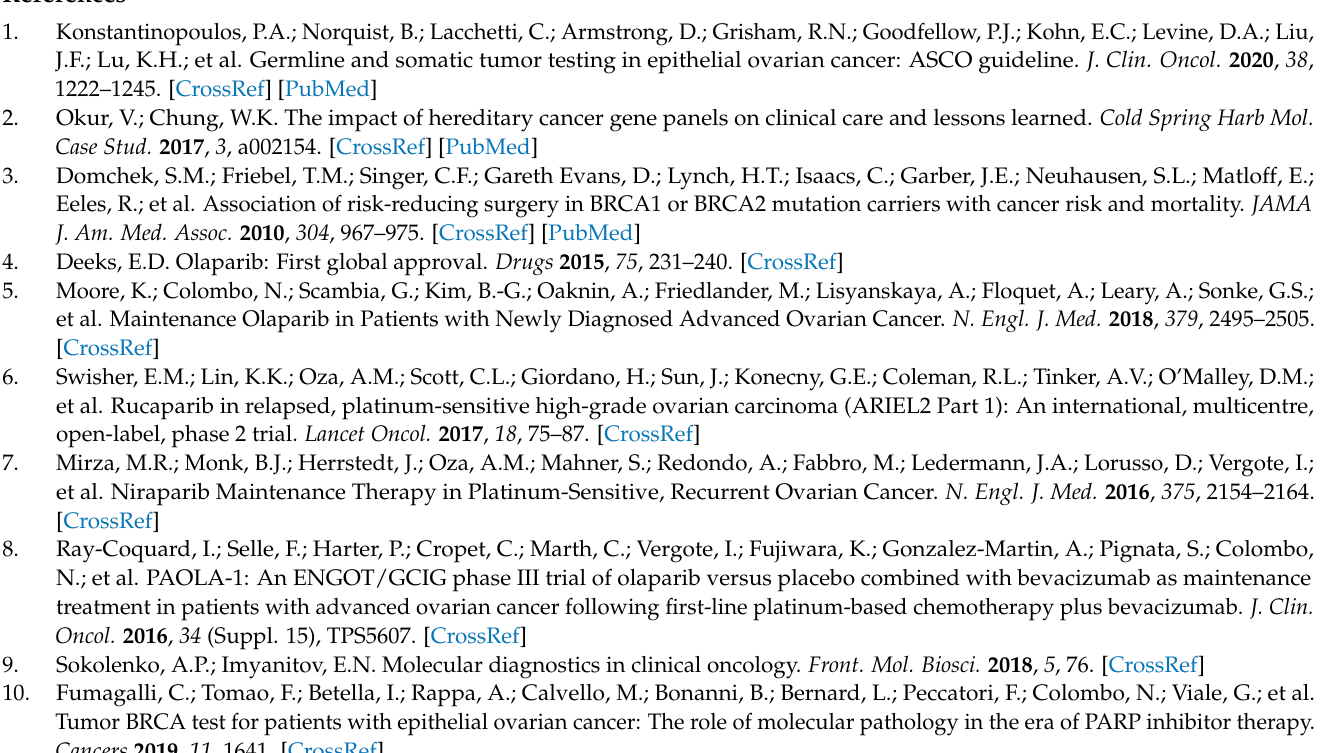
Table S1: Variants identified in HGSC tumour